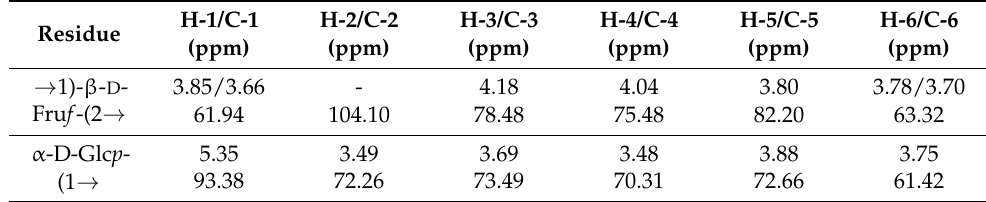
Table 1. 1 H and 13 C NMR chemical shifts of AR2.